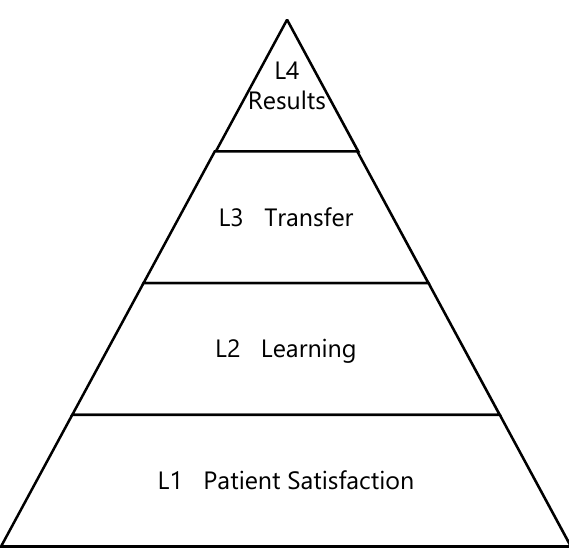
Figure 1. Kirkpatrick method—the four levels. Adapted from Kirkpatrick Partners, LLC. All rights reserved. Reproduced, with permission. Visit http://www.kirkpatrickpartners.com for more information.